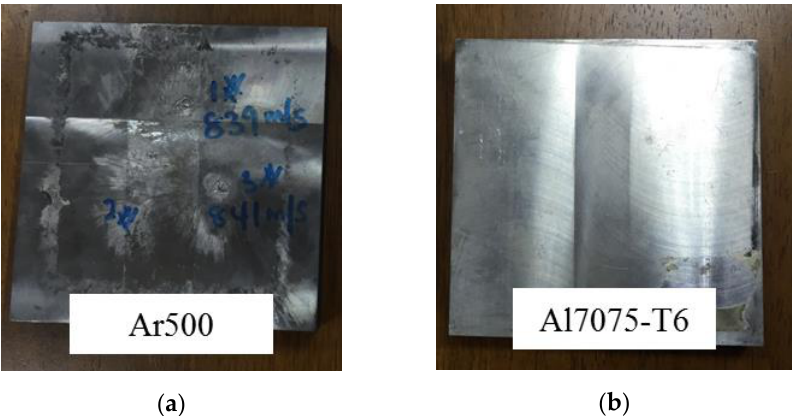
Figure 11 . Final condition of plates constituting Configuration A panel: ( a ) front layer of Ar500 steel; and ( b ) back layer of Al7075-T6 alloy.